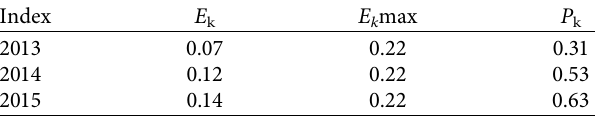
Table 4: Ecocultural bearing capacity and strength of London urban agglomeration over the years [12].